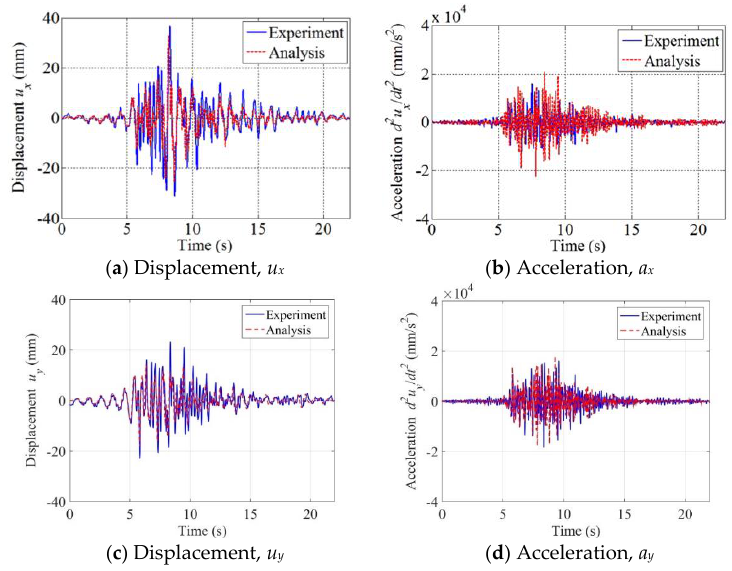
Figure 27. Numerical and experimental responses due to real Northridge earthquake of Run 19; responses sampled at point A on the third floor.